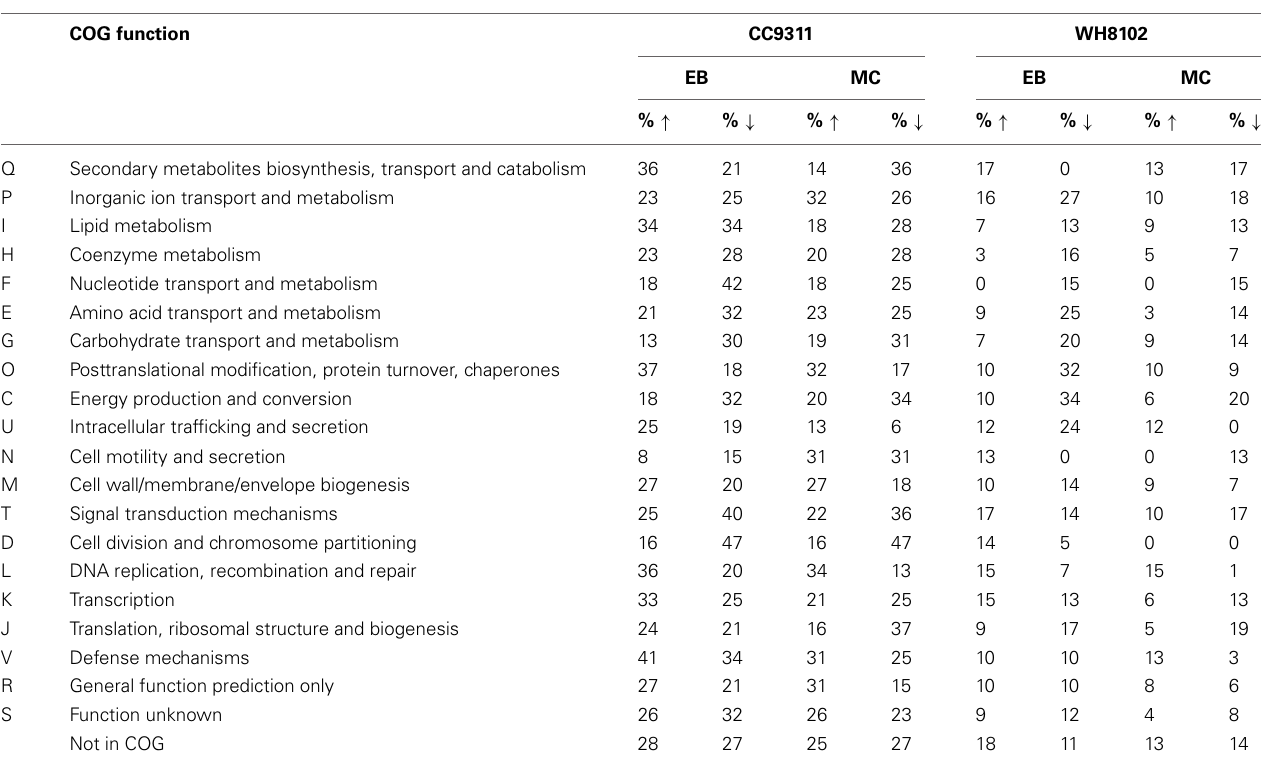
Table 2 | Proportion of Synechococcus sp. CC9311 and WH8102 genes assigned to each COG category that were significantly transcriptionally upregulated and downregulated by EB or MC